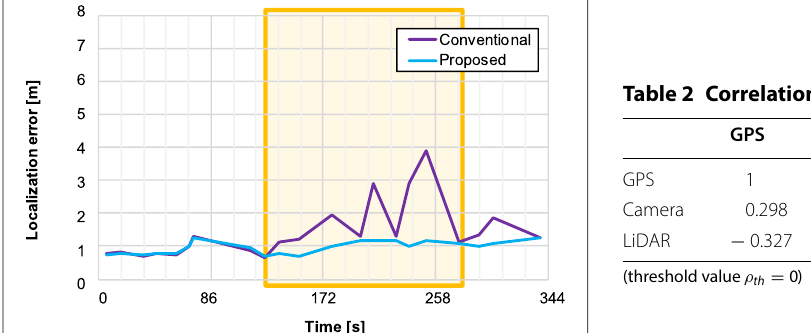
Fig. 10 Localization errors in Fig. 9